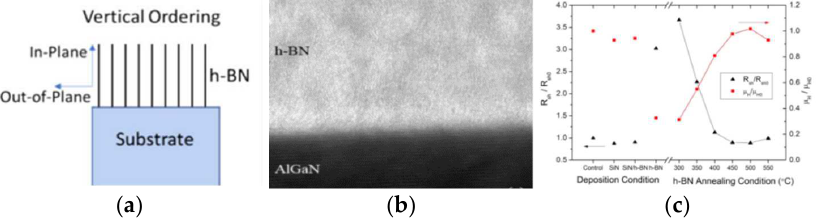
Figure 7. ( a ) Schematic diagram of vertically ordered h-BN on the substrate. ( b ) Cross-sectional HRTEM images of h-BN on AlGaN/GaN HS. ( c ) Normalized sheet resistance (Rsh) and 2DEG mo- bility (µH) of AlGaN/GaN HSs versus the different deposition conditions (control, after SiN, after h-BN/SiN, after h-BN deposition, and after postdeposition annealing temperatures). For postdepo- sition annealing, each of the samples was subjected to annealing at their respective temperatures for 300 s [50,51] .